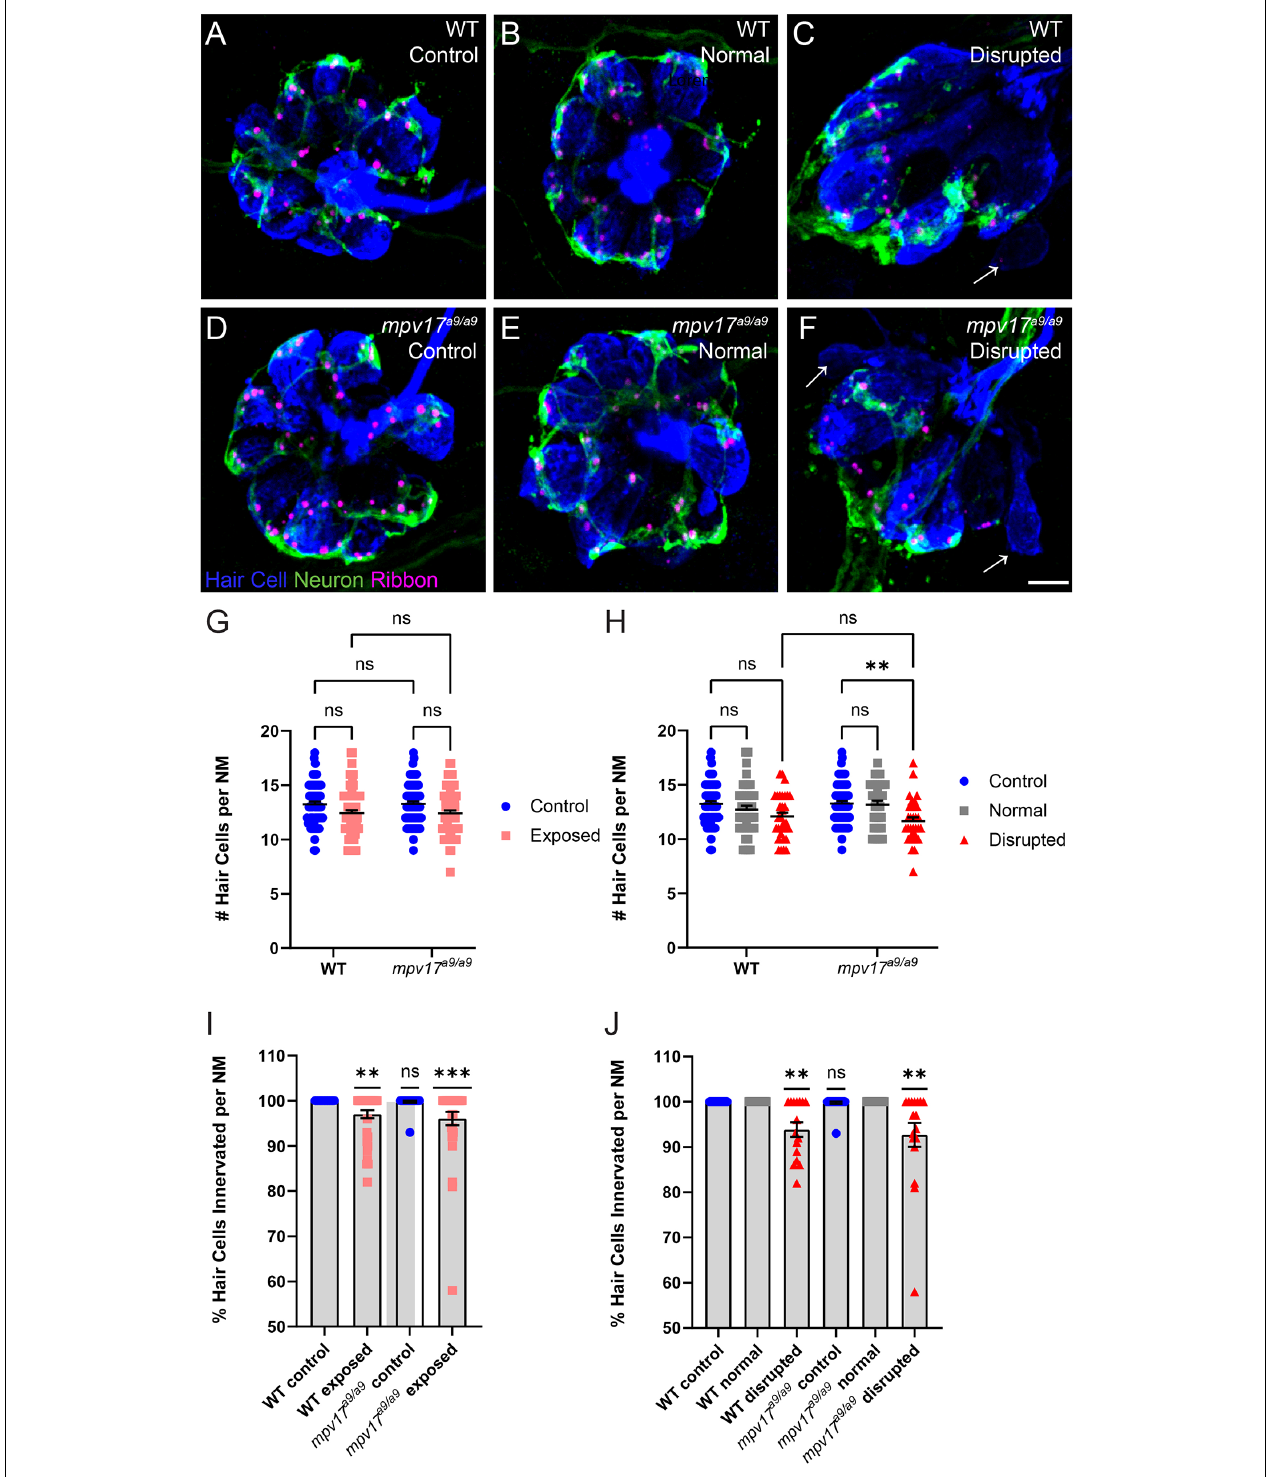
FIGURE 6 | WT and mpv17 a9/a9 neuromasts show loss of hair cells and afferent innervation following mechanical overstimulation. (A–F) Maximum-intensity projections of confocal images showing neuromasts with Parvalbumin-labeled hair cells (blue) and Ribeye b-labeled presynaptic ribbons (magenta). Neurod:GFP-labeled afferent neurites are also shown (green). Unexposed control neuromasts are shown in ( A ; WT) and ( D ; mpv17 a9/a9 ); exposed neuromasts with